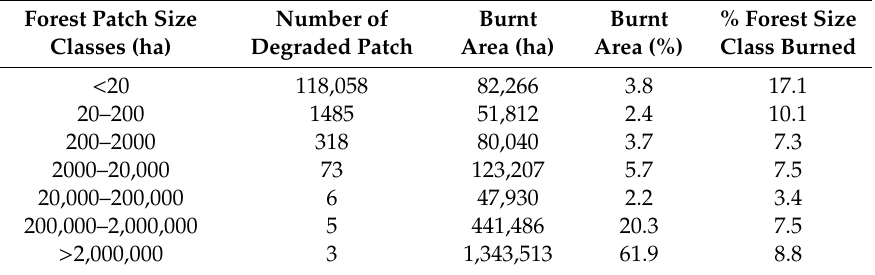
Table 4. Burned areas in the seven size classes of forest patches for the year 2019, in the Department of Santa Cruz.